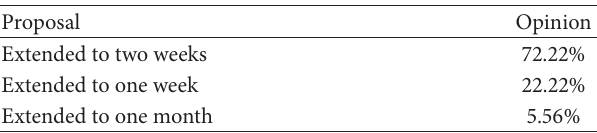
Table 4: The experts’ opinions on the time length of perichemother- apy/radiotherapy in the second round investigation.